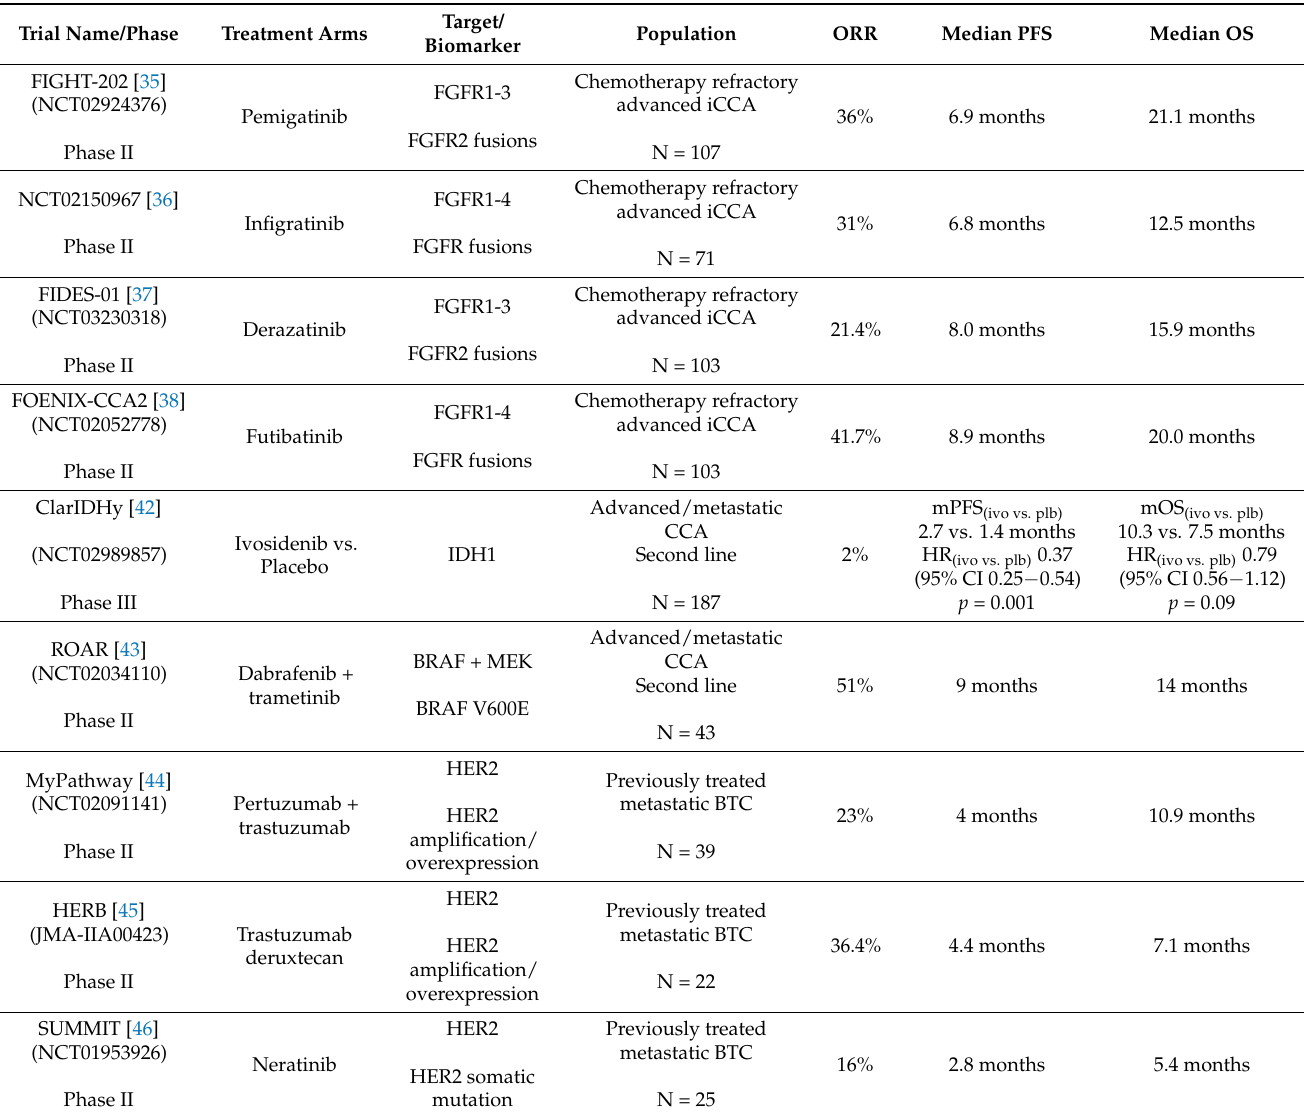
Table 2. Results reported from phase II/III clinical trials investigating biomarker-driven targeted therapy in >20 patients with advanced